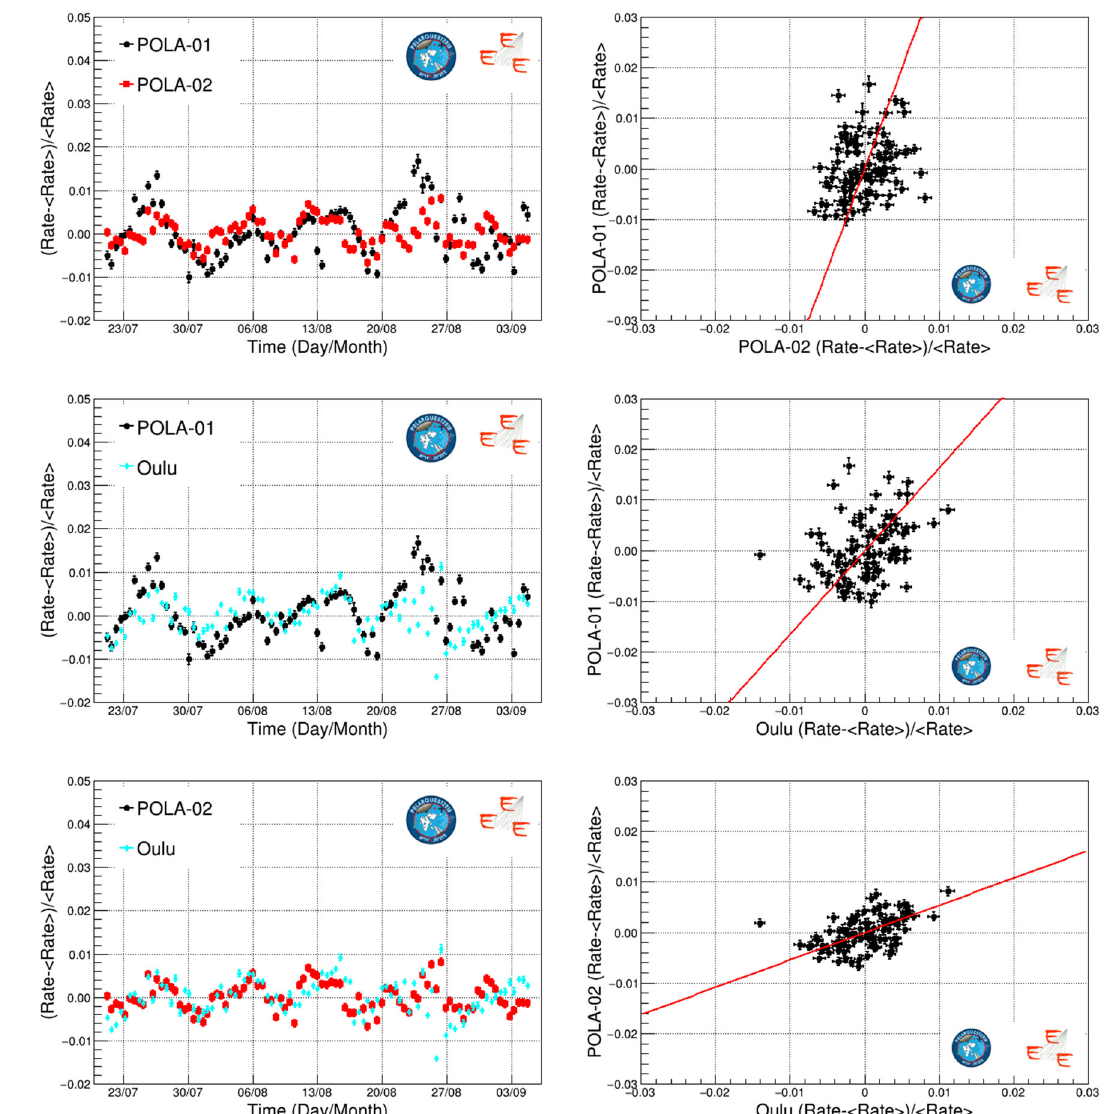
Fig. 30 Percentage rate variations as a function of the time (left col- umn)andratevariationcorrelationplot(rightcolumn).Toprow:POLA- 01andPOLA-02;middlerow:POLA-01andOulu;bottomrow:POLA- 02 and Oulu. The red line shows the fit with a linear function. The